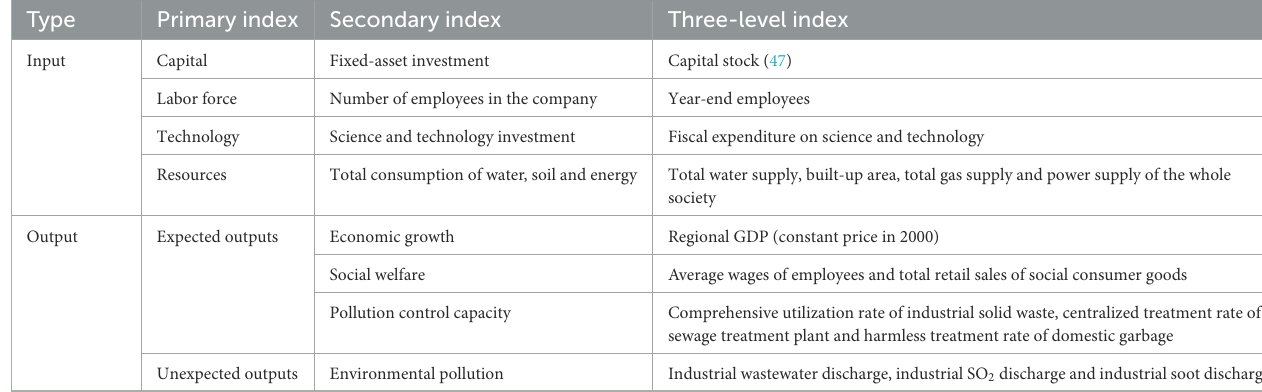
TABLE 1 Input-output index system of